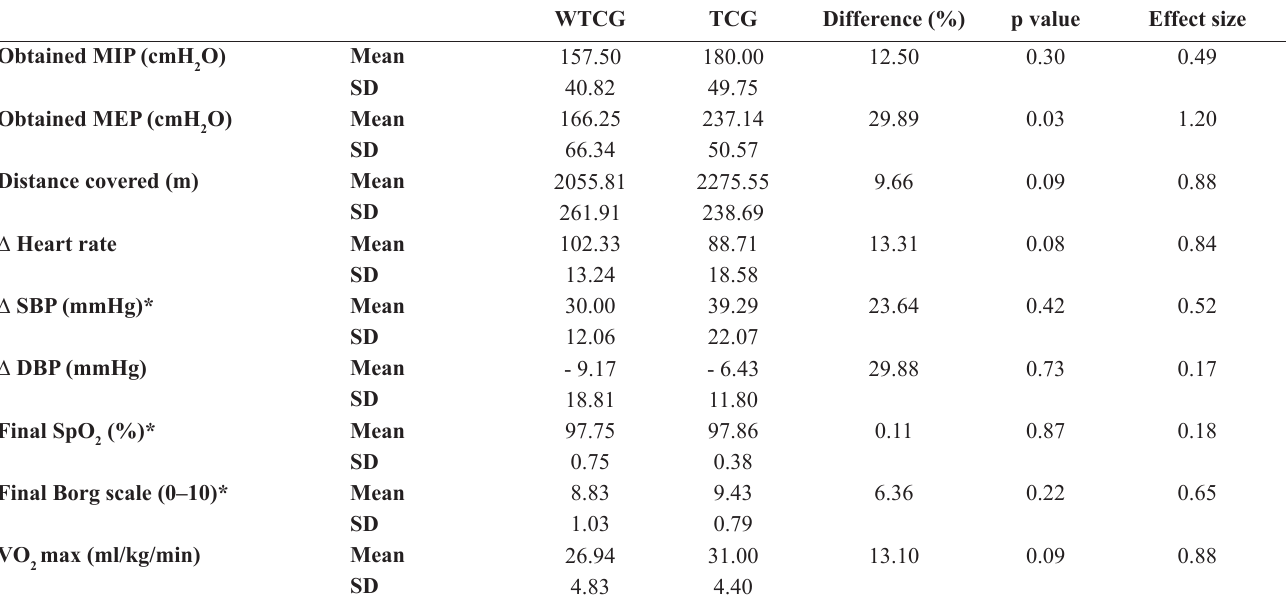
Table 4. Comparison of respiratory pressure obtained values and of the 12-minute aerobic test result between the two groups. WTCG TCG Difference (%) p value Effect